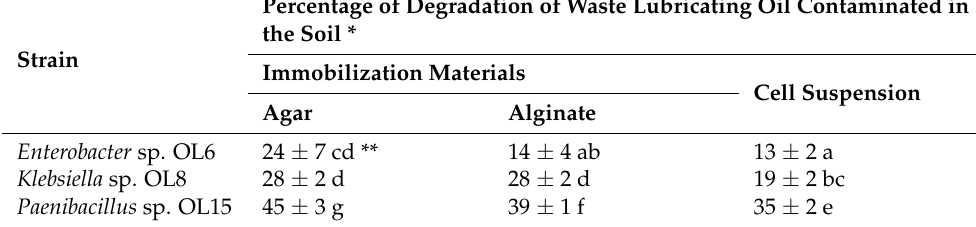
Cell Suspension